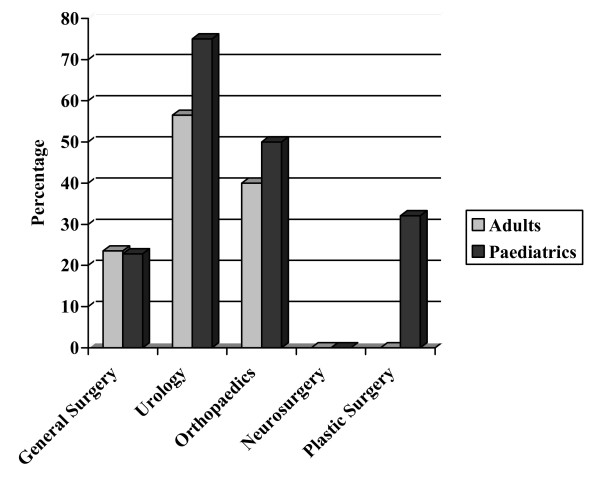
Cancellation by surgical specialties. (Percentage refers to the proportion of patients cancelled despite attending the preanaesthetic clinic)